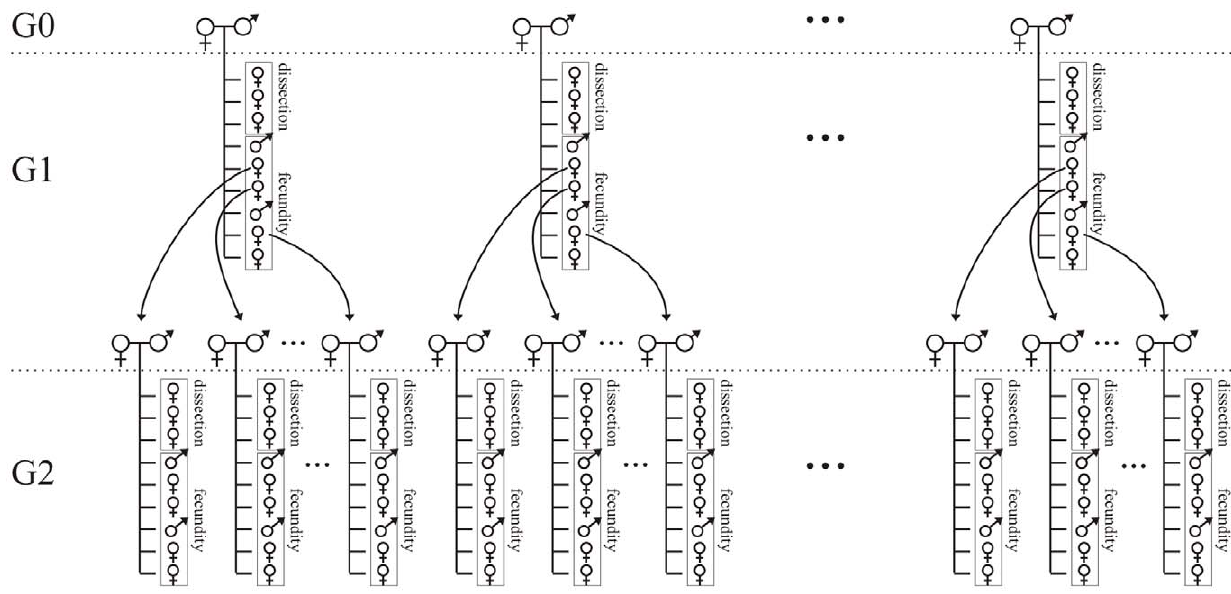
Figure 1. Representation of the design used to quantify genetic variation in the RCI in Trichogrammabrassicae . The Reproductive Concentration Index (RCI) quantifies the relative degree to which females concentrate egg production into very early life. Females dissected up to 24 h after emerging from the host egg were used to compute the numerator of the RCI ( i.e. , egg load). By the time these females were sampled, they had attained at most only 6.5% of their potential lifespan. The remaining females provided data to estimate the denominator ( i.e. , lifetime realized fecundity, measured under conditions of available food and an excess of hosts). With this protocol, the genetic variation in RCI was estimated in two ways: (1) by computing/testing the regression between G1 and G2 (over two successive generations; i.e. , a ‘mother-daughter regression analysis’), and (2) by comparing the different families (only three of them are represented in this figure) at the G2 generation (a so-called ‘family analysis’).